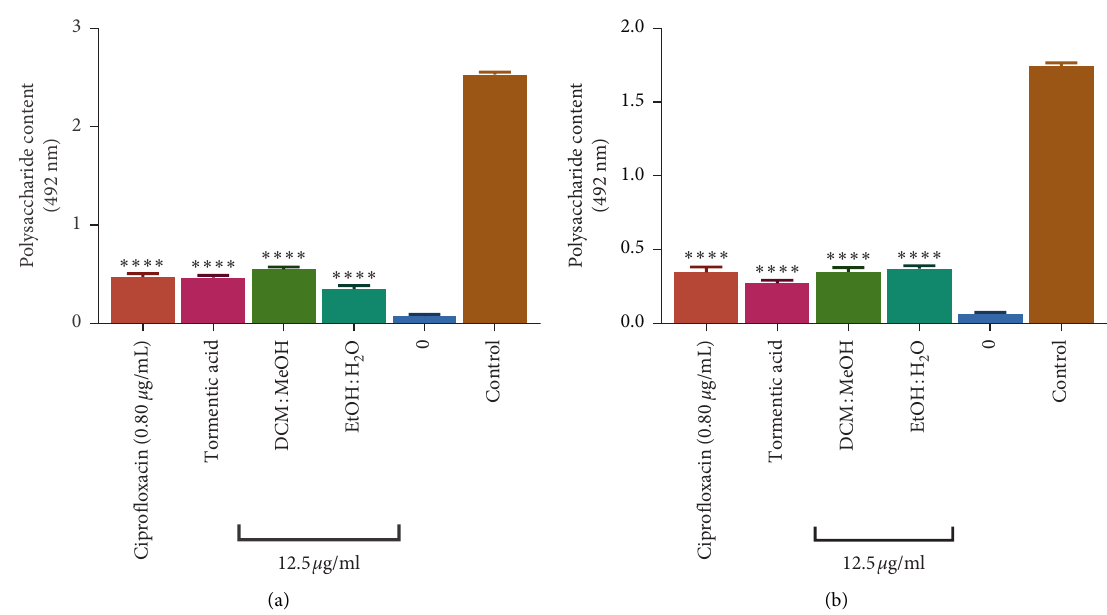
Figure 8: The effect of C. viminalis EtOH:H 2 O extract, DCM:MeOH extract, tormentic acid congener, and ciprofloxacin on biofilm polysaccharide content. P. aeruginosa (a) and S. aureus (b) were incubated in a medium containing 0.80 µ g/ml ciprofloxacin and 12.5 µ g/ml of extracts and tormentic acid congener for 16 hours. Mannose was used as the standard for carbohydrate content. Carbohydrate content was read at 492nm using a Stat Fax model microplate reader. ANOVA was carried out using GraphPad Prism6 and Dunnett’s multiple comparisons test with a summary of ∗∗∗∗ P value <